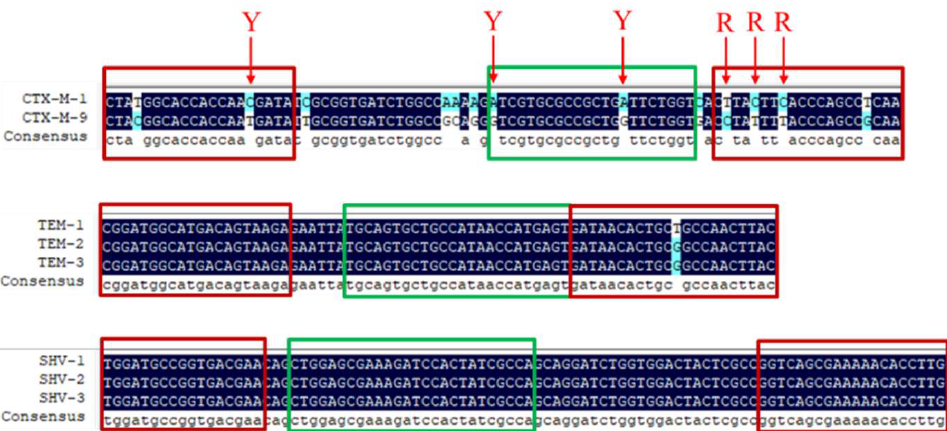
Figure 3. Design of probes and primers for detecting bla CTX-M , bla SHV , and bla TEM genes.